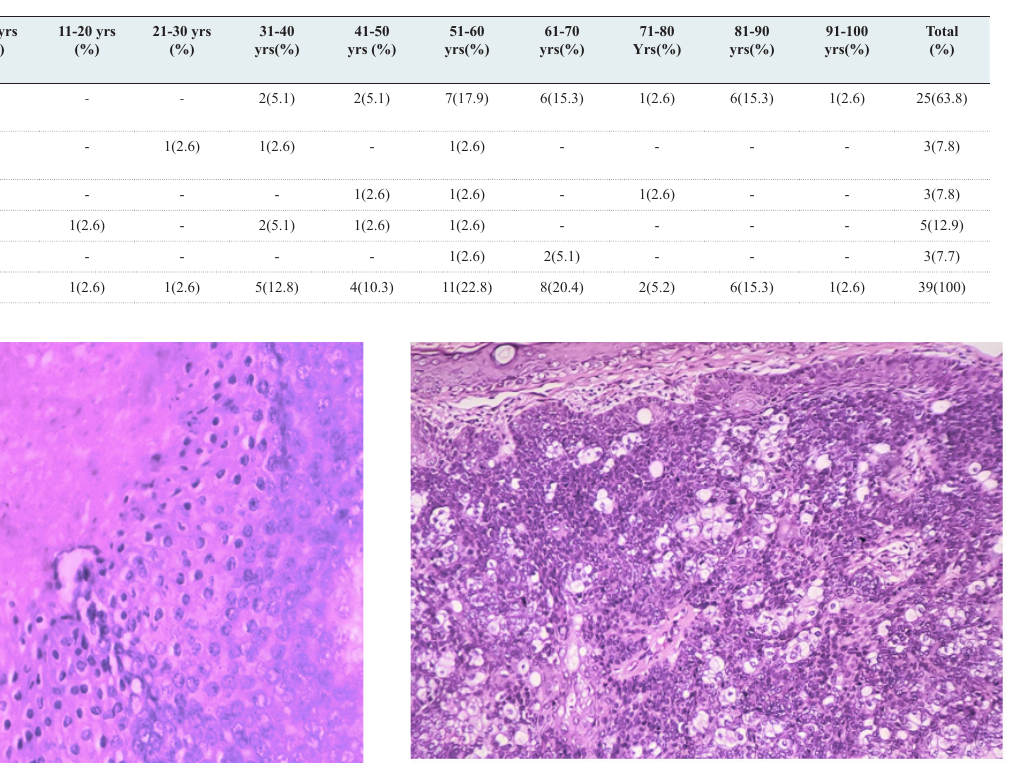
Table 5: Distribution of malignant skin neoplasms in various age groups